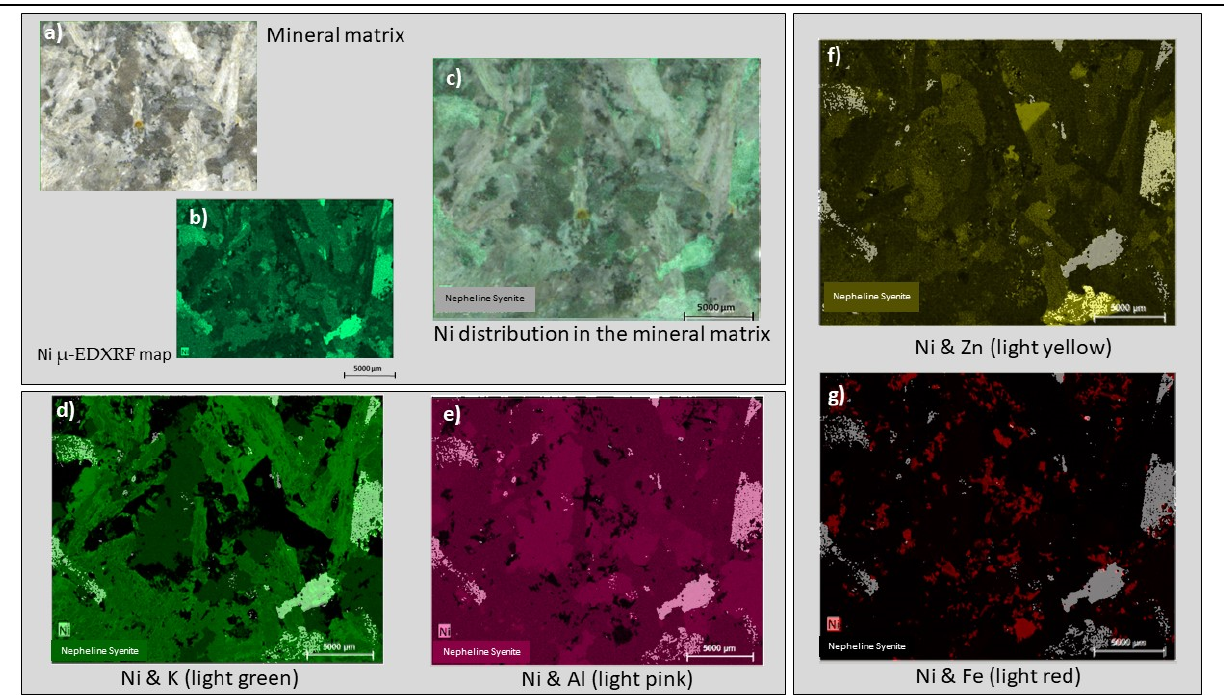
Figure 7. ( a ) Image of original mineral sample (mineral matrix), ( b ) Ni μ‐ EDXRF map, ( c ) Ni distribution in the mineral matrix (overlap of images ( a )), and Ni distribution and its correlations with ( d ) K, ( e ) Al, ( f ) Zn, and ( g ) Fe.